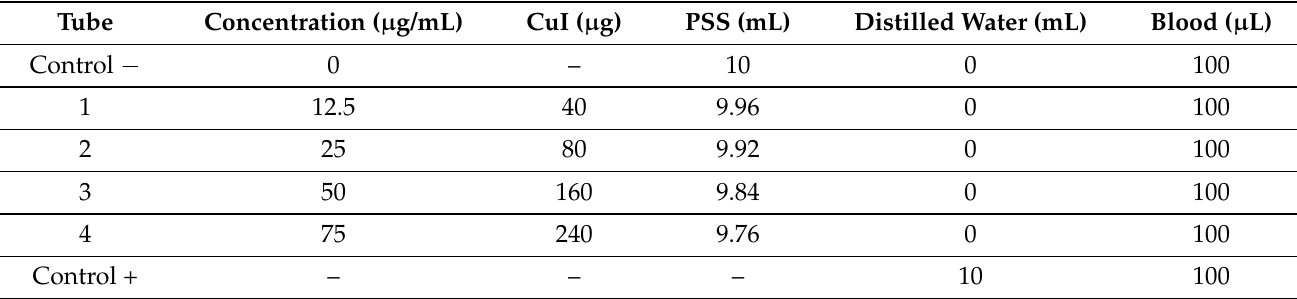
Table 2. Determination of the biocompatibility of CuI@polymer composites. The exposure of RBCs was evaluated at different composites concentrations.